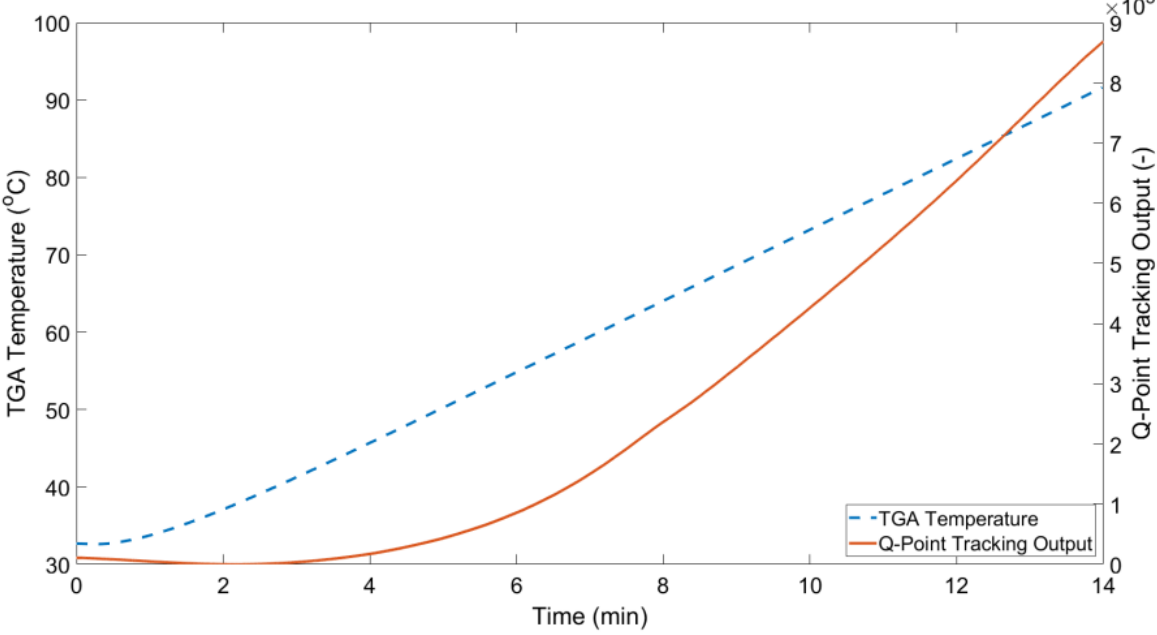
Figure 14. Change of intensity at 1541 nm in the PVA diaphragm based temperature sensor interference